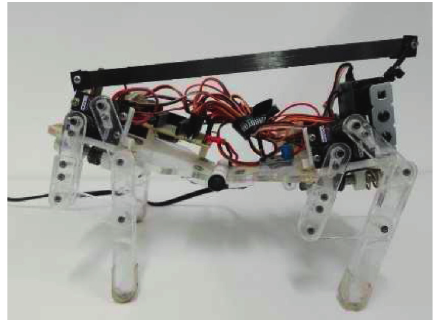
Figure 1: Robot’s side view.